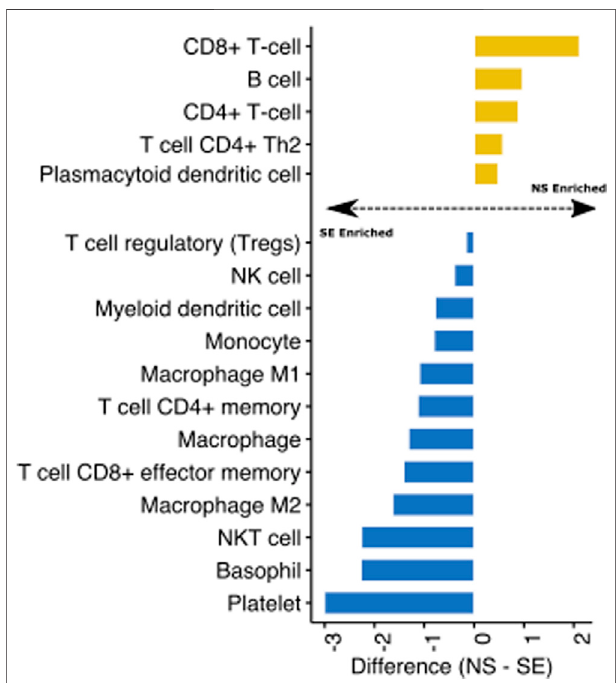
FIGURE 4 | Identi fi cation of UV-mediated reprogramming of skin immune cell pro fi le. Bar plot depicting the mean difference between the Decosus immune cell estimates for non-sun exposed skin (NS) and sun- exposed skin (SE) (n = 1879). The plot shows only immune cells signi fi cantly different between the two groups at p -value <